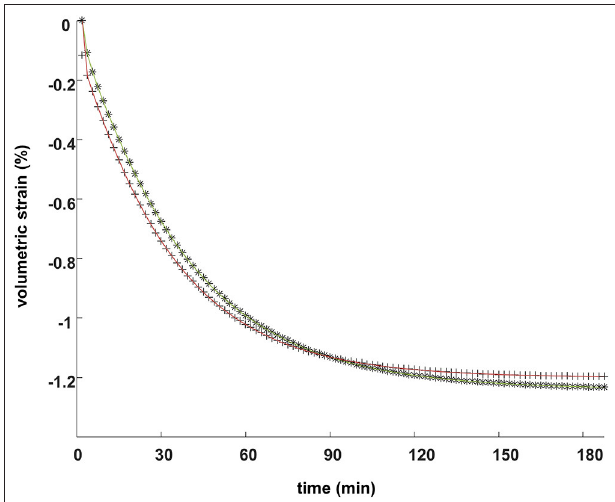
FIGURE 9 | The FEM predictions (plotted symbols) of the volumetric strain behavior over time, spatially averaged across all radial positions, compared with the analytical predictions of Equations (7) and (12) (solid lines), in the strain relaxation (olive lines and stars) and the stress relaxation (brown lines and crosses) compressions of a